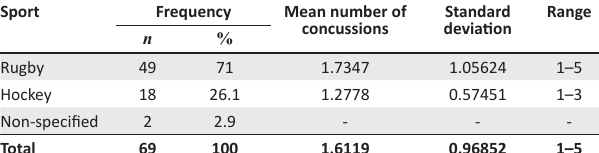
TABLE 1: Prevalence of concussion by sport ( n = 221).